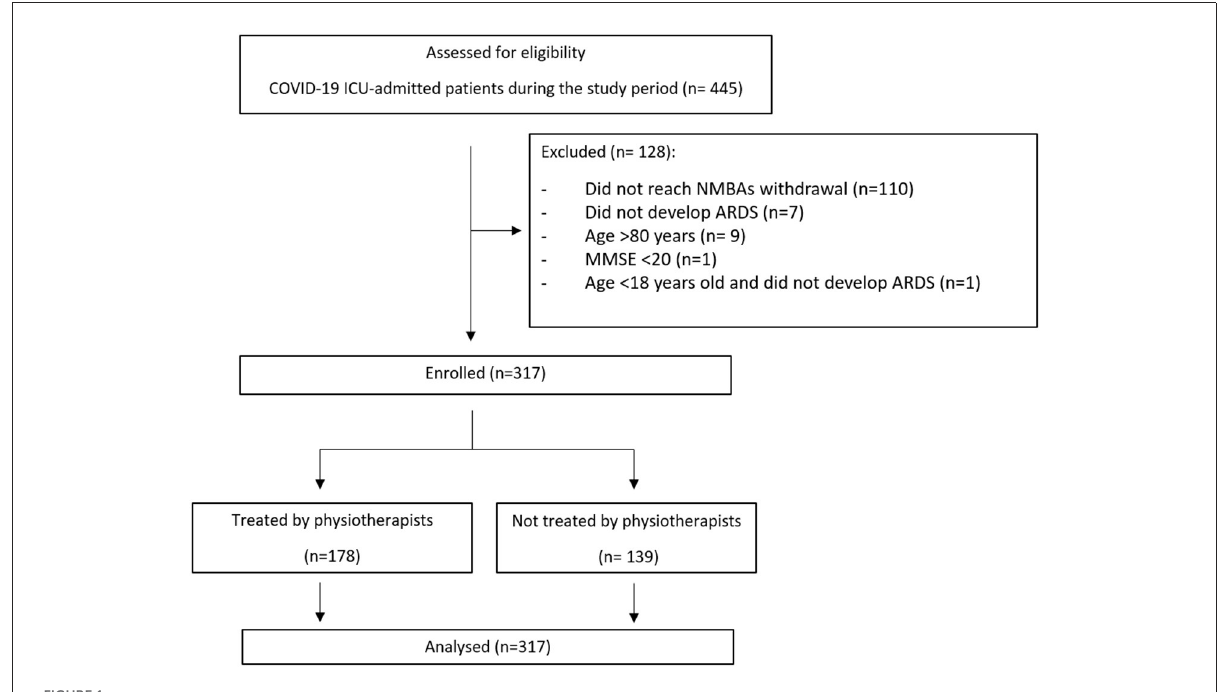
FIGURE1 STROBE flow